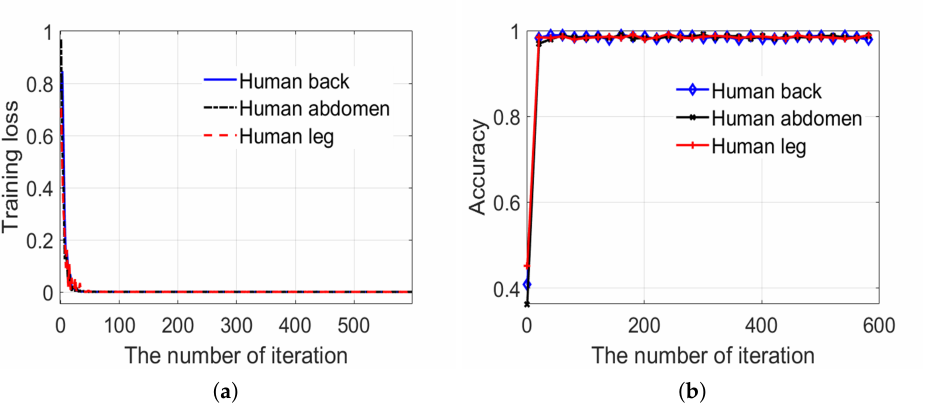
Figure 9. Variation of training loss and testing accuracy in the training process of sub-network 1.